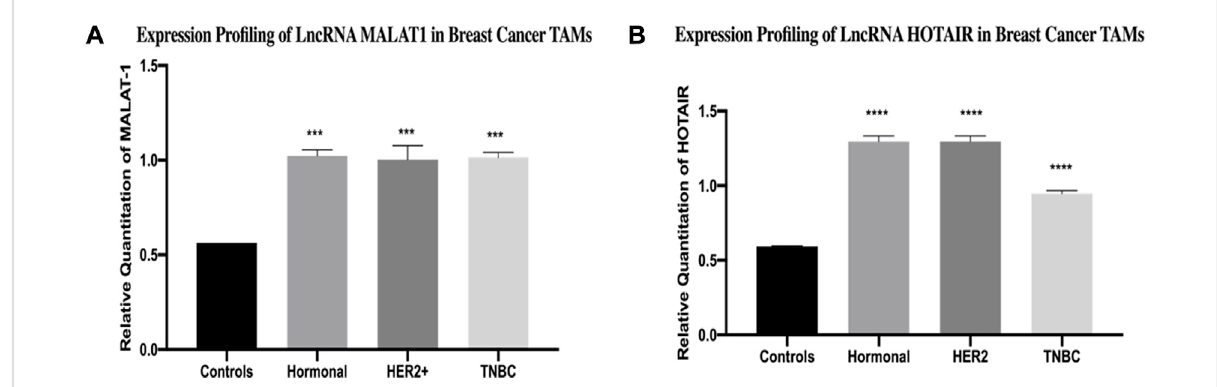
FIGURE 1 Expression pro fi ling of LncRNA MALAT1 and HOTAIR in breast cancer TAMs. q-PCR was performed for the quantitative analysis and expression pro fi ling of the MALAT1 and HOTAIR levels in BC subtypes (hormonal, HER2+, and TNBC) compared to healthy donors. The results showed signi fi cant upregulation of (A) MALAT1 and (B) HOTAIR in hormonal, HER2+, and TNBC compared to healthy donors. One-way Anova followed by Dunette ’ s test of multiple comparison was used for the purpose of comparison between more than two different studied groups. **** = p